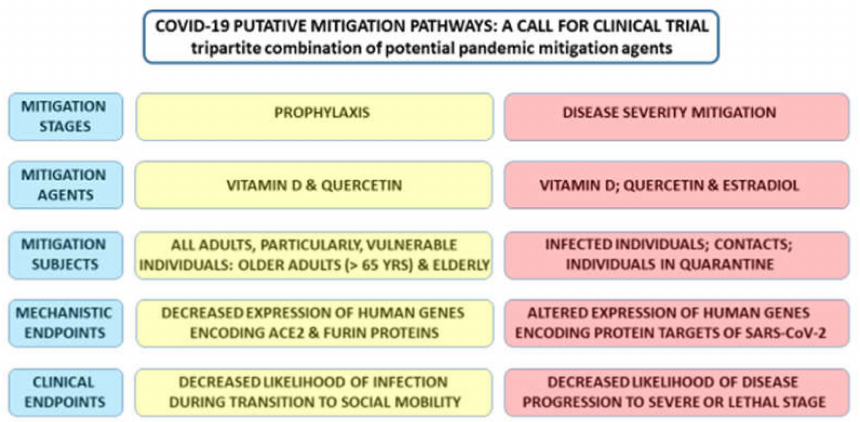
Figure 8. Proposed mitigation approaches for prophylaxis and treatment of the COVID-19 pandemic based on prescriptions of bipartite (vitamin D and quercetin) and tripartite (vitamin D / quercetin / estradiol) combinations of candidate